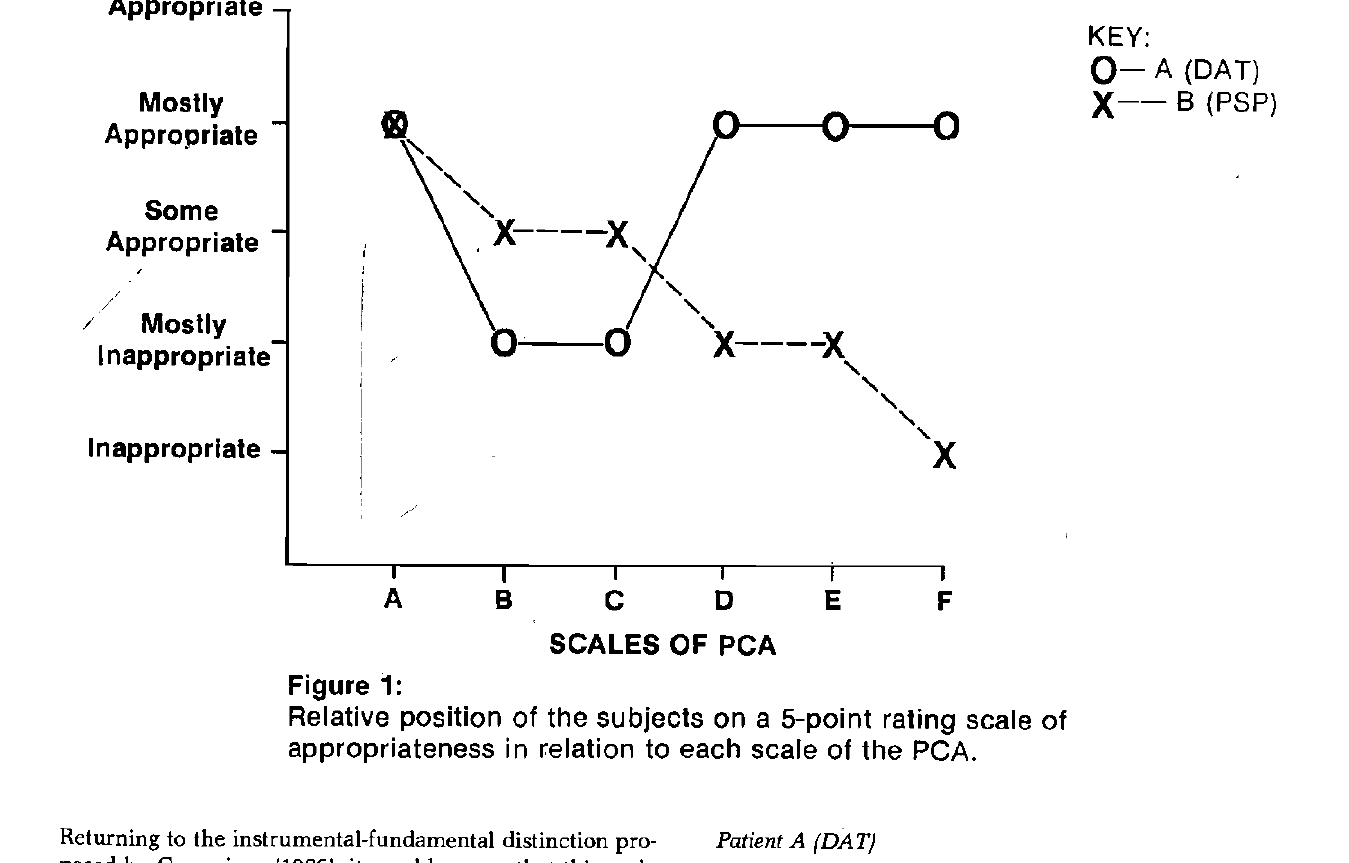
Relative position of the subjects on a 5-point rating scale of appropriateness in relation to each scale of the